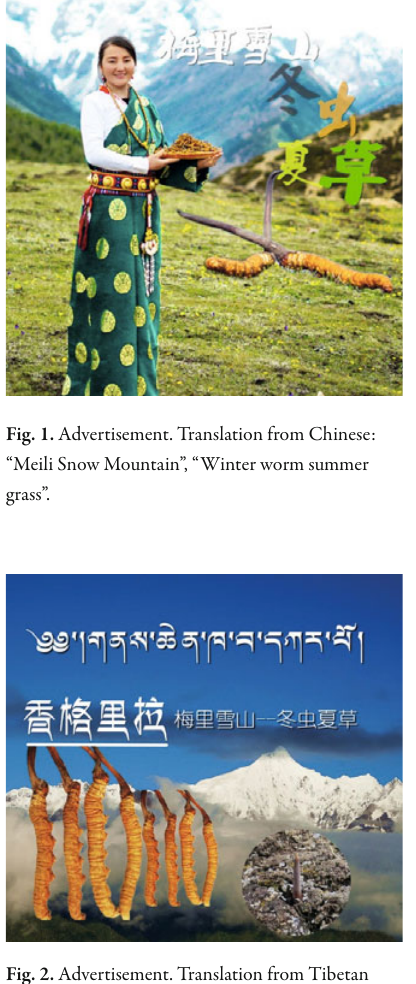
Fig. 2. Advertisement. Translation from Tibetan (upper line): “The pilgrimage place Khawa Karpo”. Translation from Chinese (lower line): “Shangri-La”, “Meili Snow Mountain—Winter worm summer